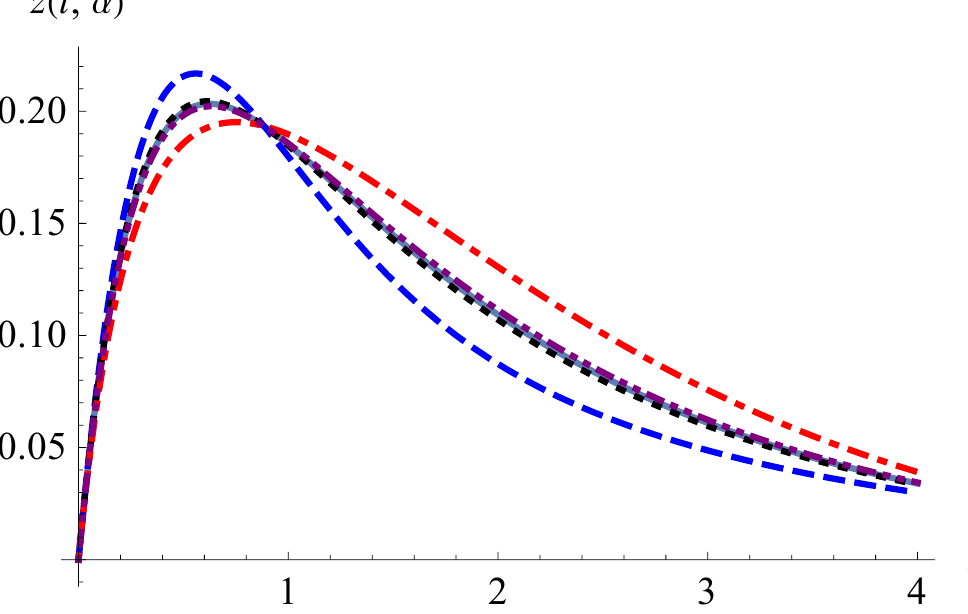
Figure 16. Curves of z ( t ;1 ) (solid line) and z ( t ; α ) for α = 0.9 (dash line), 0.99 (dot line), 1.1 (dot-dash line), 1.01 (dot-dot-dash line), where b = 4 and c = 2 ( b 2 − 4 c >